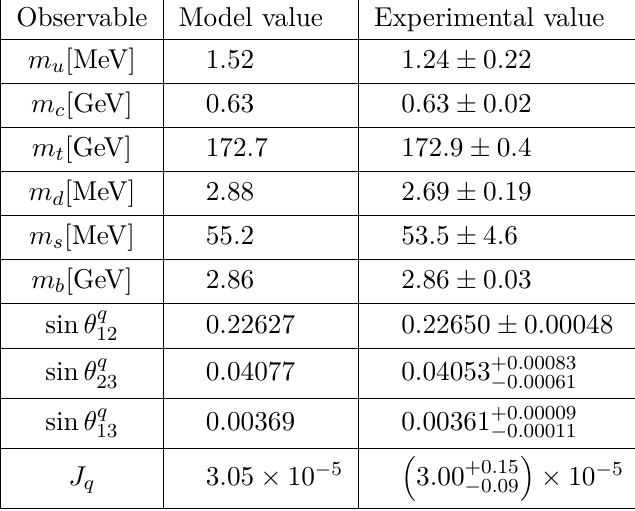
Table 4 . Model and experimental values of the quark masses and CKM